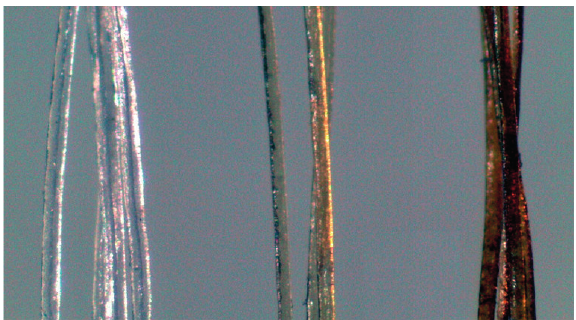
Figure 4. Color of hair is altered with gold nanoparticles in a time-dependent